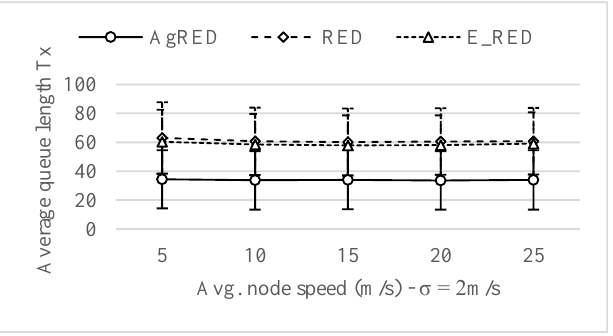
Figure 9. Average and standard deviation of queue length Tx vs. average node speed.